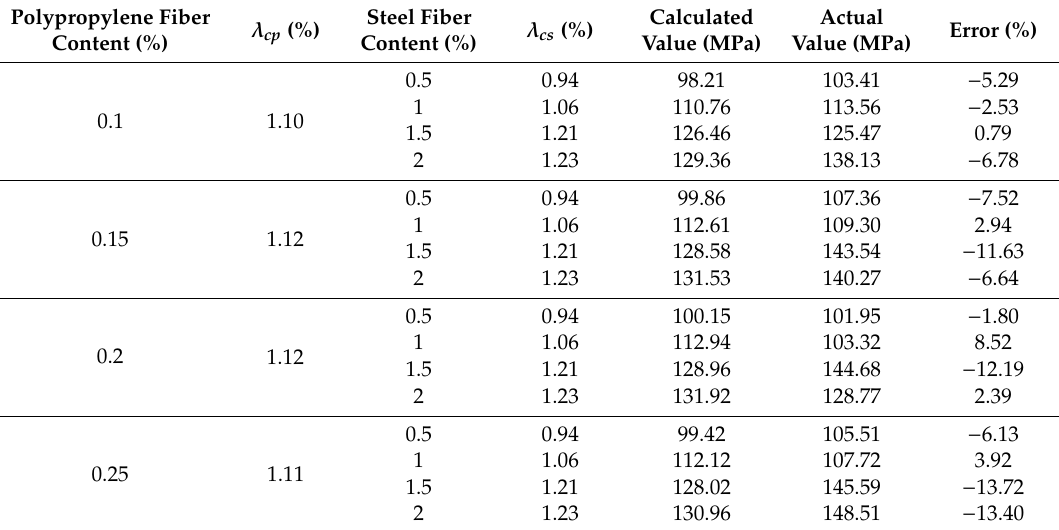
Table 16. Hybrid polypropylene-steel fiber RPC compressive strength